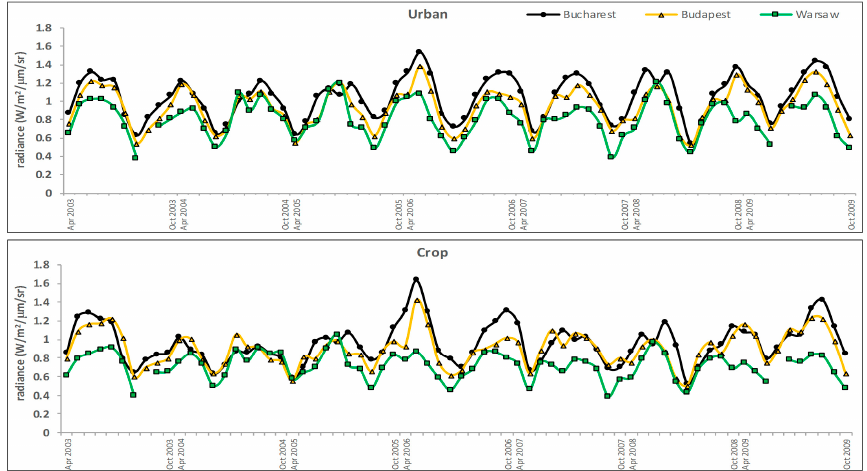
Figure 10. Time series chart of MIR radiance for urban ( top ) and cropland ( bottom ) classes from April to October over 2003–2012.